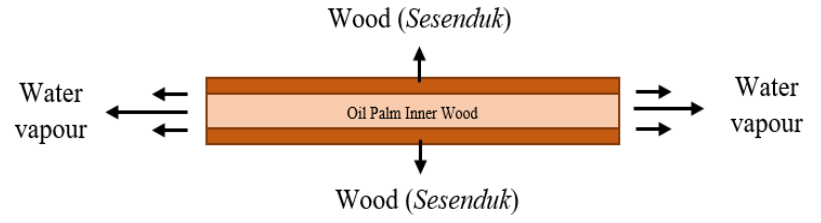
Figure 7. Water vapor release from a sample of laminated compreg OPW composite laminated with sesenduk during compression progress.